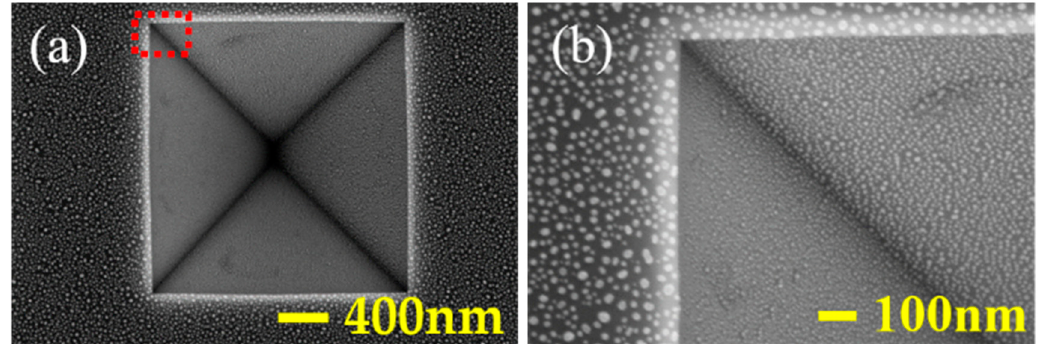
Figure 3. SEM images of randomly distributed Au NPs after annealing ( a ) top view, ( b ) zoomed in view of Au NPs at selected positions in ( a ).